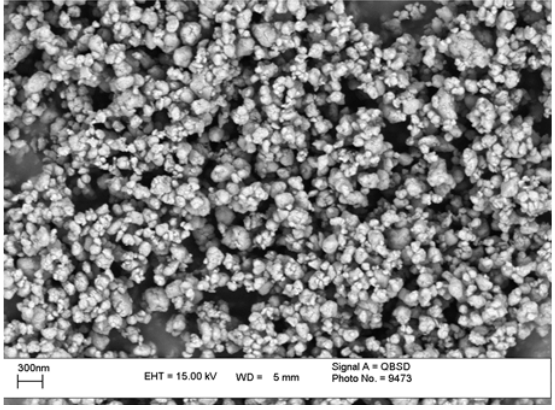
Figure 1. SEM images of magentic nano structures Fig. 1. SEM images of magentic nano